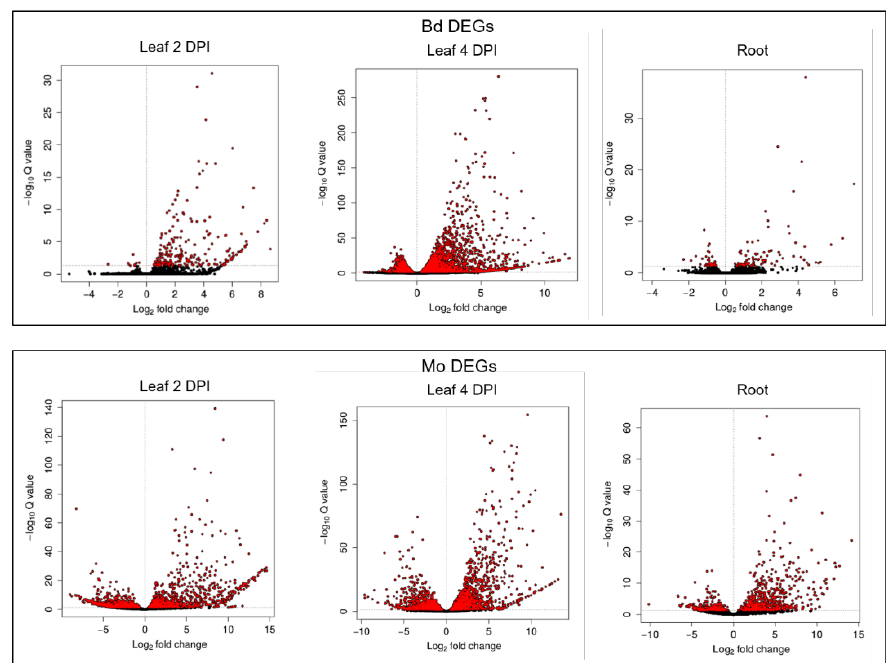
Figure 4. Volcano plots of DESeq2 results based on mRNAseq analysis of M. oryzae -infected leaves and roots of B. distachyon vs. control. Differentially expressed genes (DEGs) are highlighted in red with significant adjusted p -values (padj < 0.05).